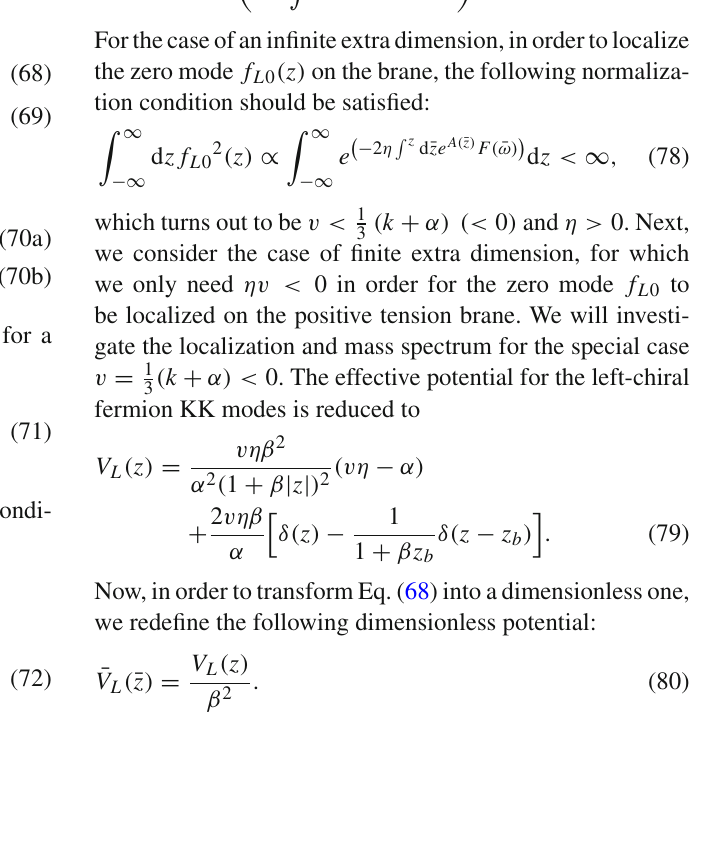
Fig. 8 The mass spectra of the vector KK modes. The parameter k is set to k = −